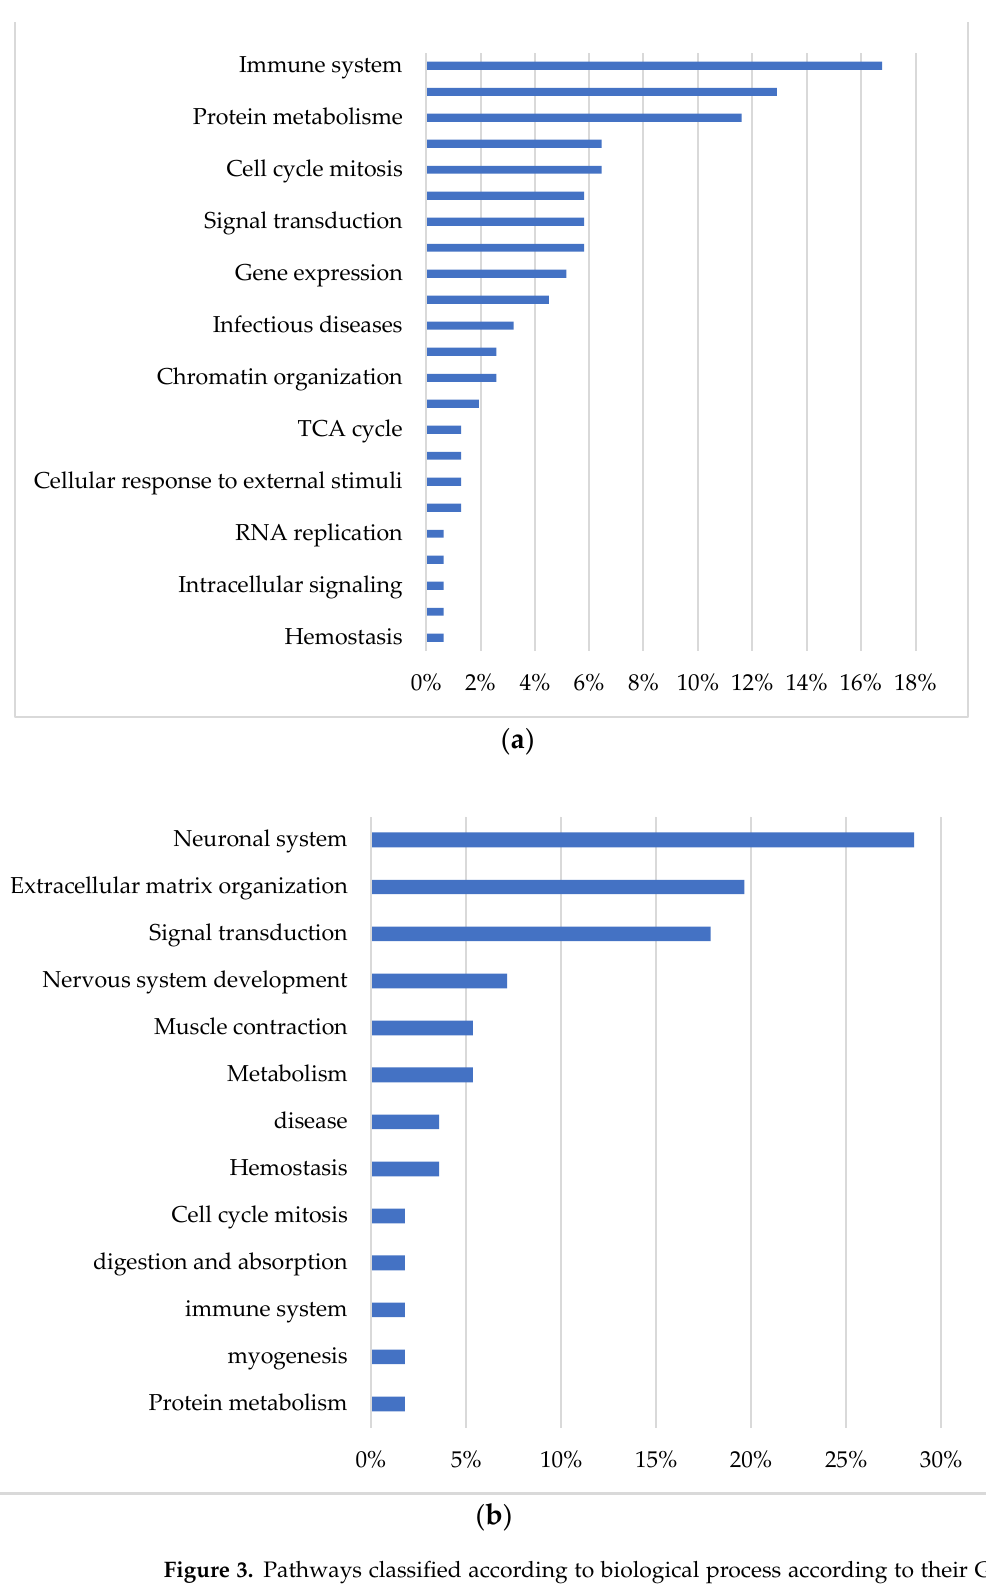
Figure 3. Pathways classified according to biological process according to their GO classification ( a ) Down-regulated pathways in the XLA group in relation to the PC group; ( b ) Up-regulated pathways in the XLA group in relation to the PC group. PC = Positive control with medicinal zinc oxide, XLA = Extra low protein diet with non-marked amino acids.